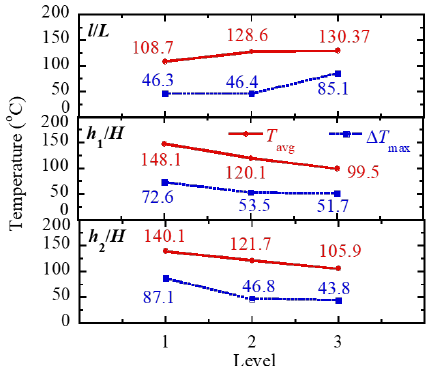
Figure 7. Main effects of three control factors on T avg and ∆ T max . Three subgraphs from top to bottom show the main effects of l / L , h 1 / H , and h 2 / H .